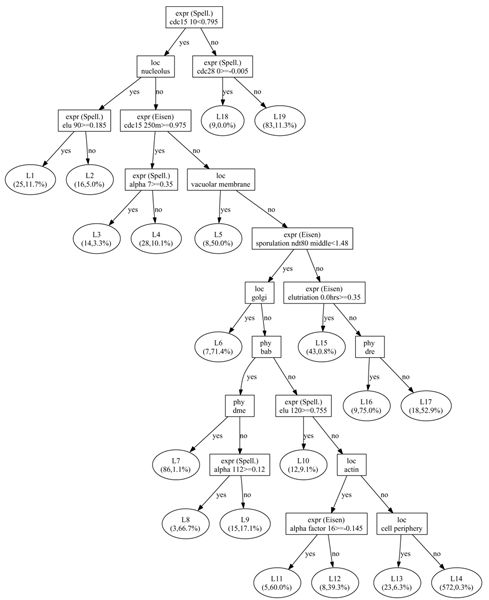
Decision tree. A decision tree obtained on the protein-protein interaction network using expression data, phylogenetic profiles and localization data as inputs. The tree size was determined by cost-complexity pruning with 10-fold cross-validation. The left (resp. right) edge from a test node corresponds to the test of the node being true (resp. false). Each leaf is labeled with a pair (N, p), where N is the number of proteins in its cluster and p is the percentage of protein pairs that interact in the cluster.